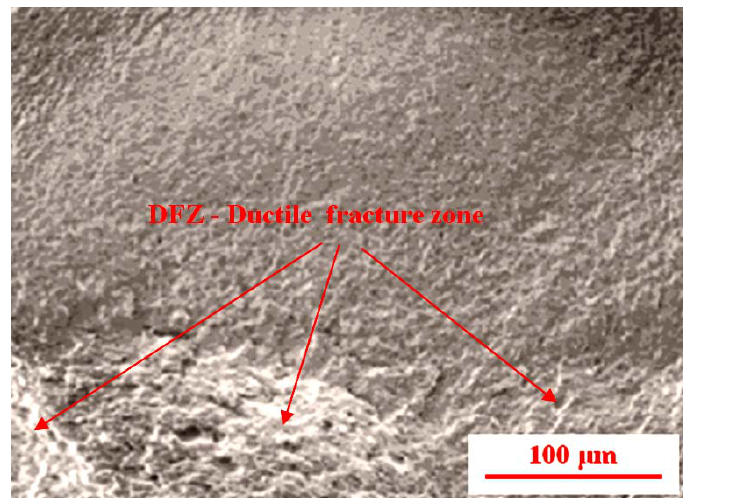
Figure 7 – (SEM) fracture morphologies of NiAlMo coatings deposited with a powder feed rate of 30 g/min Рис . 7 – ( СЭМ ) Морфология трещин в NiAlMo покрытии , нанесенном